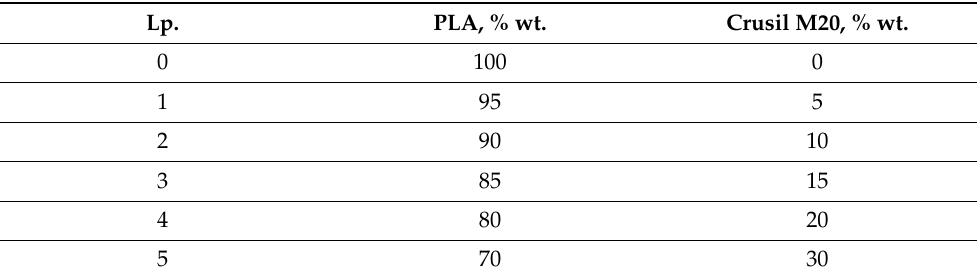
Table 3. Composition of individual PLA + Crusil M20 mixtures.